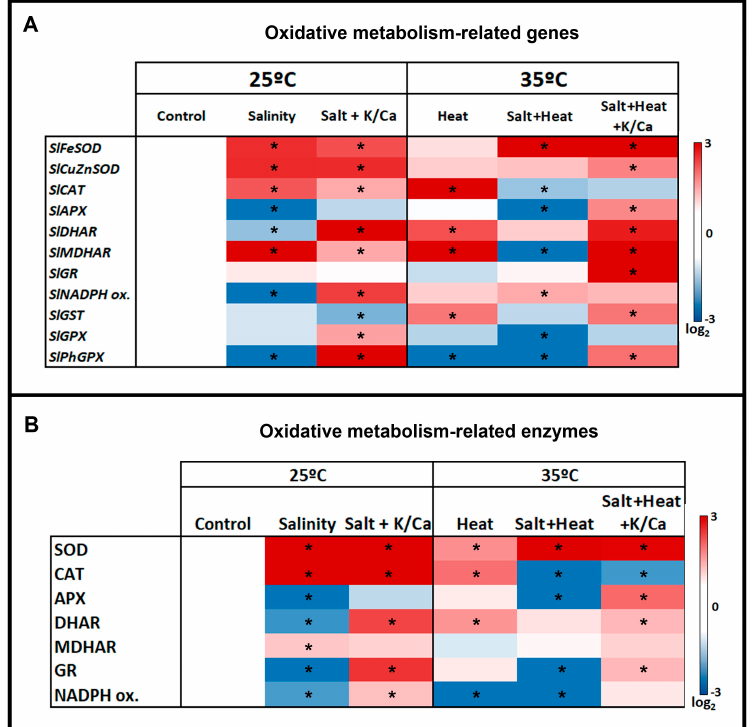
Figure 5. Oxidative metabolism-related gene expression ( A ) and enzymatic activities ( B ) in tomato leaves grown under control, salinity (60 mM NaCl) or salinity and higher concentration of K + and Ca + 2 in the irrigation solution at optimal temperature (25 ◦ C) or heat stress (35 ◦ C). Red color represents a higher relative expression or activity with respect to control plants and blue color represents a lower relative expression or activity. Scale is the log 2 values of the expression after normalization with respect to control plants. Absolute values (gene expression and enzymatic activities) as well as log2 values can be found in Supporting Information Tables S2–S5, respectively. Asterisks are representative of significant di ff erences with respect to control plants ( p <